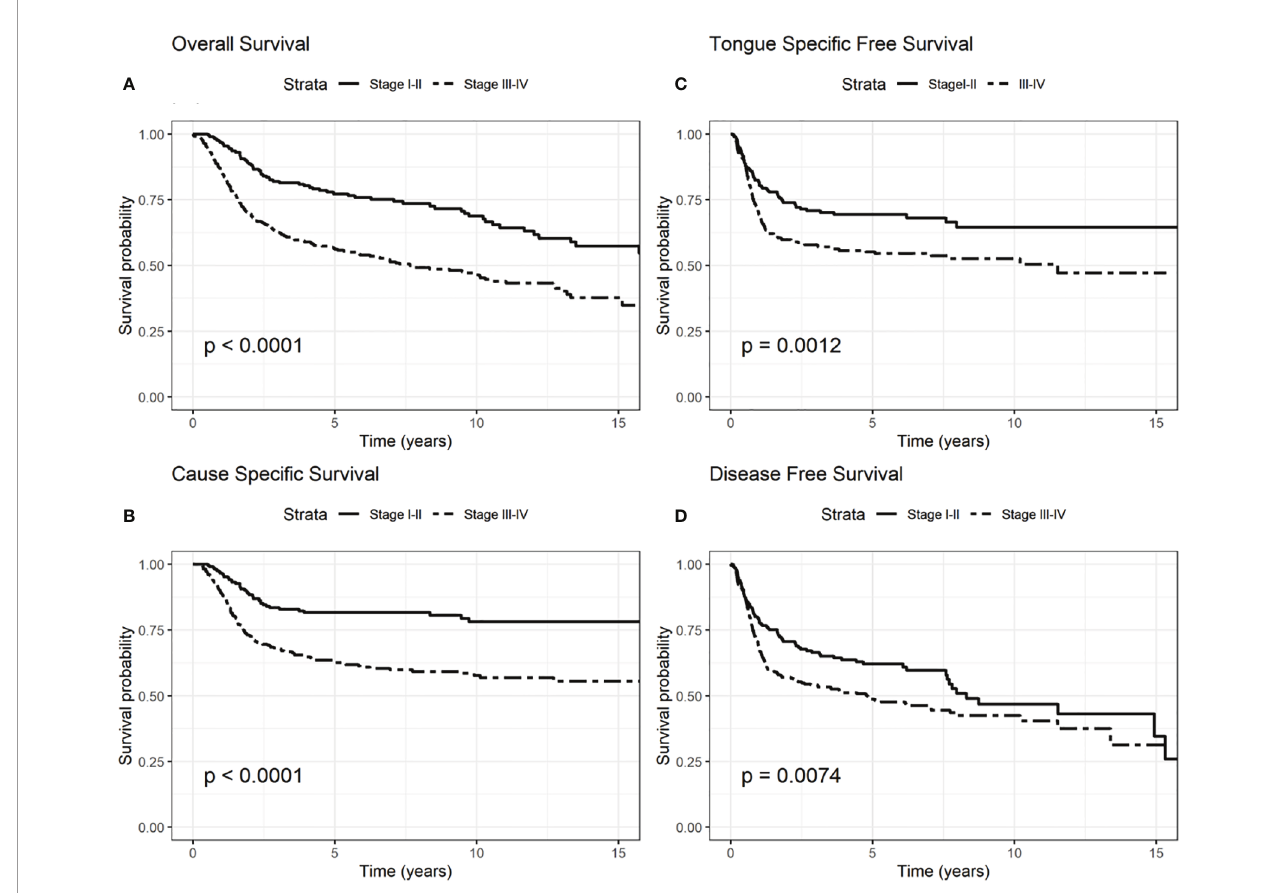
FIGURE 3 | Survival probability: overall survival (OS) (A) , cause-speci fi c survival (CSS) (B) , tongue speci fi c free survival (TSFS) (C) , disease-free survival (DFS) (D) according to stages I – II and III – IV according to the 8 th edition.